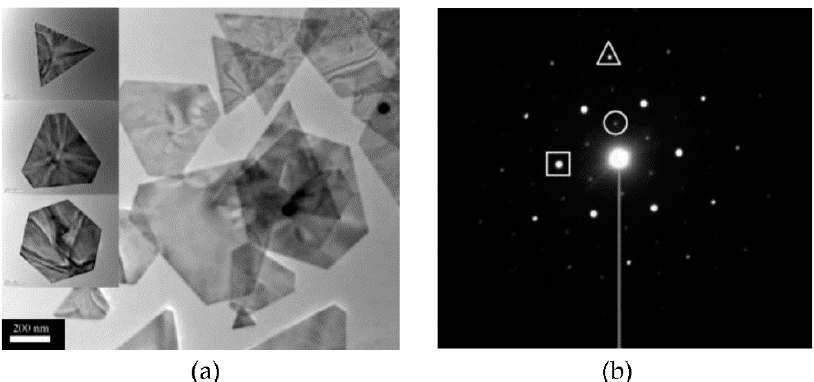
Figure 1. ( a ) TEM images of gold nanoplates obtained from the reduction of chloroaurate using seaweed extract. ( b ) The selective area electron diffraction (SAED) pattern of a triangular nanoplate. The strongest spots (square) could be assigned to the {220} reflections, the outer spots (triangle) with weaker intensity could be indexed to the {422} reflections, and the inner spots (circle) with the weakest intensity correspond to the formally forbidden 1/3 {422} reflections. Adapted with permission from [32]. Copyright © 2021, American Chemical Society.